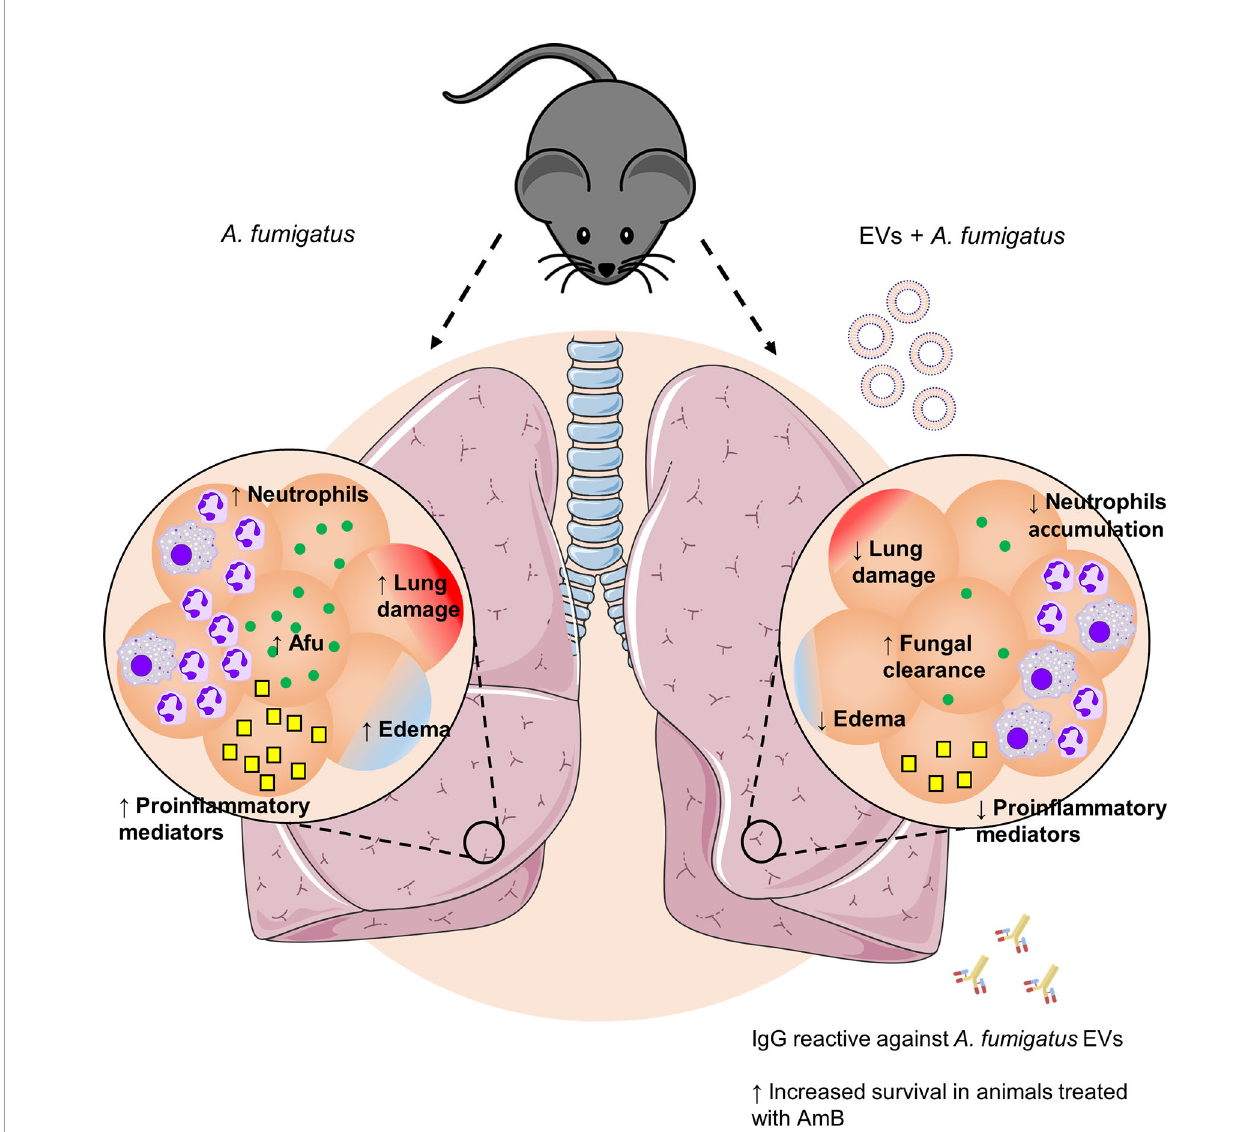
FIGURE 6 | Effects of immunization with A. fumigatus EVs. Pulmonary infection by A. fumigatus promotes an increase in neutrophil in fi ltrate to the alveoli. The increase in the in fl ammatory in fi ltrate is supported by a growth in production of pro-in fl ammatory mediators, which culminates in the formation of edema and lung injury. Immunization with A. fumigatus EVs modulates the in fl ammatory in fi ltrate to the lungs, characterized by a reduction in the accumulation of neutrophils and in the production of pro-in fl ammatory mediators. In addition, it stimulates fungal clearance mechanisms. This control is mediated, in part, by the presence of speci fi c antibodies, which, combined with treatment with low doses of AmB, are able to protect animals from a fatal